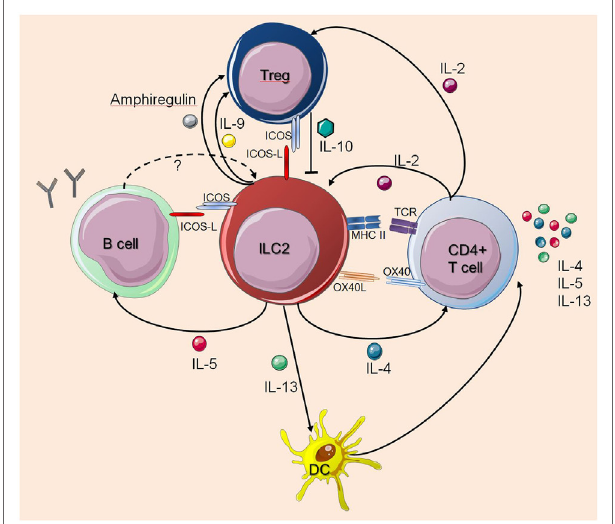
FigURe 1 | Interactions between innate lymphoid cells (ILC2s) and T cells or B cells. The figure illustrates how ILC2s interact with T cells or B cells as described in the main text. The dashed arrow indicates a potential feedback regulation for which there is currently no experimental evidence. Solid arrows indicate published evidence for activating mechanisms whereas Treg-derived IL-10 was shown to suppress ILC2s. Cell symbols where taken from http:// smart.servier.com